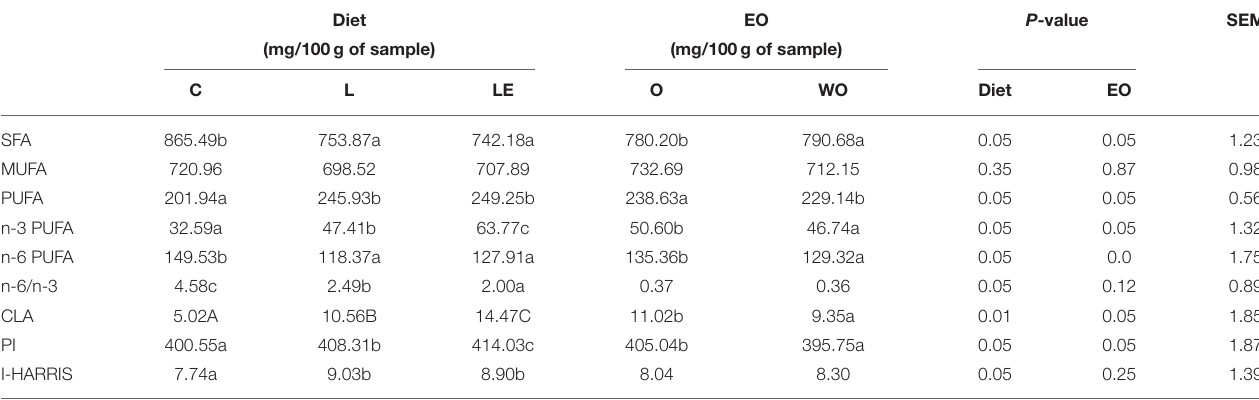
TABLE 5 | Effects of experimental diets (C, L, and LE) and treatment (EO) with (O) and without essential oils (WO) on health indices and pro-oxidant fatty acids on Marchigiana beef meat at 9 days of storage. Diet EO P -value SEM (mg/100g of